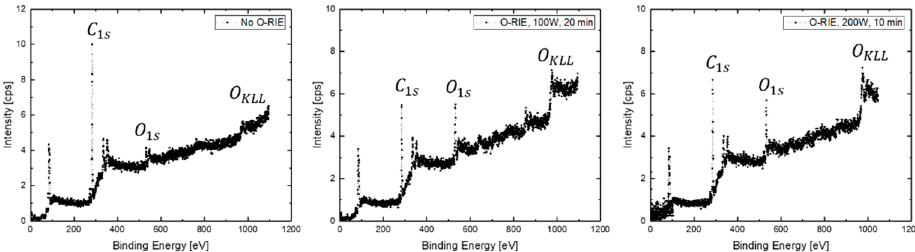
Figure 8. XPS survey scan spectra, respectively, for sample surfaces without O-RIE (left), with 100 W O-RIE (middle), and 200 W O-RIE (right) processes.